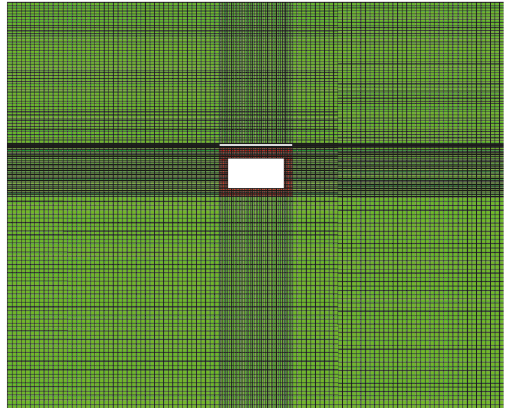
Figure 10: Model 1 built up based on FLAC 3 D for numerical calculation.